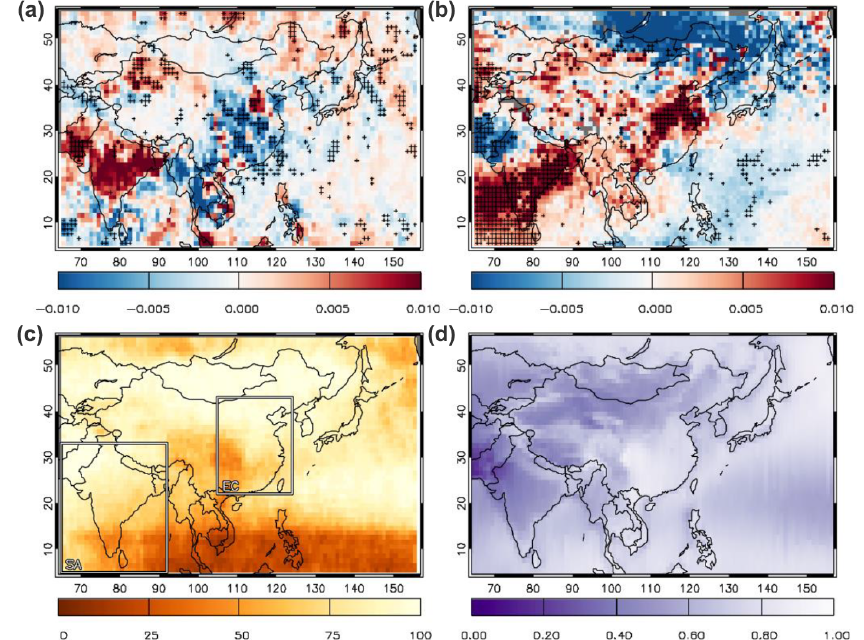
Figure 8. Trends in Aqua MODIS and CALIOPCALIPSO AOD at 532nm over South and East Asia for the period January 2007–December 2015: CALIOPCALIPSO trends in AOD at 532nm (a) and the number of months used in the CALIOPCALIPSO time series (c) ; Aqua MODIS C6 AOD at 550nm trends in DTDB merged datasets (b) and mean cloud fraction (d) . Symbol “ + ” denotes trends statistically significant at the 95% confidence